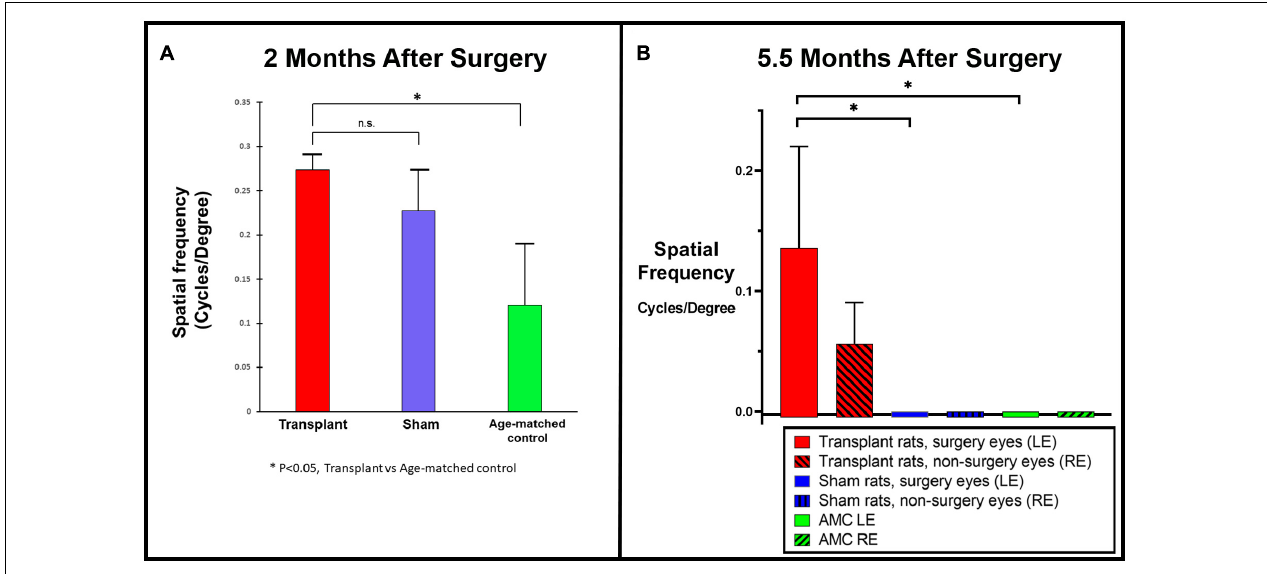
FIGURE 4 | Optokinetic testing. (A) Improved visual acuity in the transplanted group revealed by OKT testing at 2 months post-surgery using OKT setup 1 (USC). A new setup that consisted of two tablet screens to display the OKT visual stimuli (high contrast black and white stripes) was used (manuscript under preparation). OKT responses at various spatial frequencies were assessed based on the presence or absence of head-tracking response. When tested at the 2 months post-surgery, higher visual acuity was observed in co-graft transplanted rats ( n = 5) compared to sham ( n = 4, not significant, unpaired t -test) and age-matched non-surgery control rats ( n = 4, * p < 0.05, unpaired t -test). (B) OKT testing at 5.5 months post-surgery using OKT setup 2 (Cerebral Mechanics Inc.). Transplant surgery eyes (left, red bars) with co-graft show higher visual acuity compared to the fellow eyes (right, red bars with shading) of the same rats without transplants